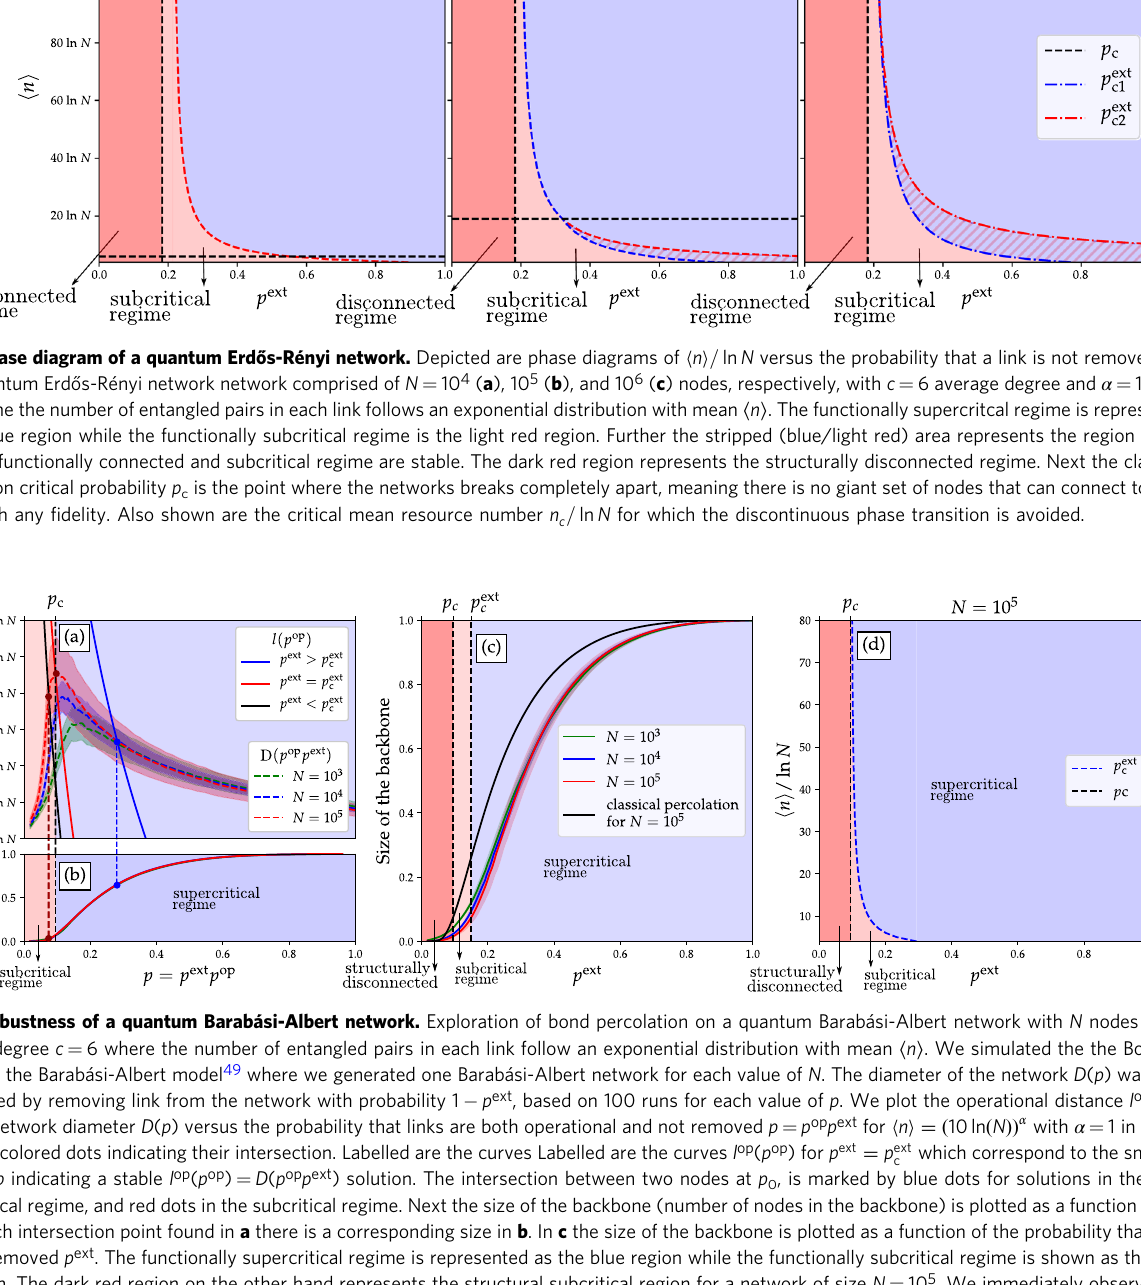
¼ def D ð p Þ . This provides quite an interesting insight into this D max c apparent change of behavior. It is well known that the classical percolation critical value p c tends to zero with the network size for (this is what the Barabási-Albert network 43 , but so does D max prevents the suppression of the phase transition). This means that the decrease of p ext can be mitigated by increasing the average c ð c 2 Þ